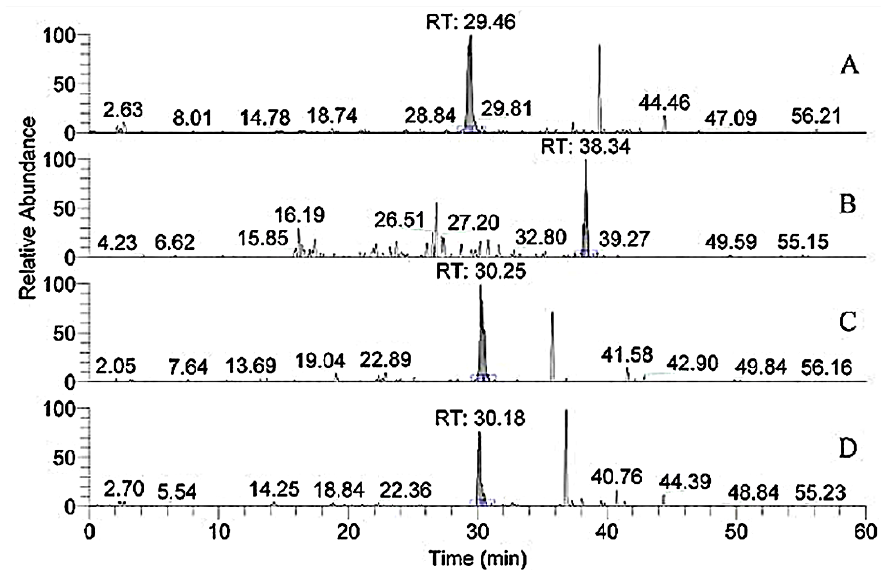
Figure 6. Extracted ion chromatogram of the peptides, numbers 1–4, in Table 1. ( A ) m / z 796.8; ( B ) m / z 1042.3; ( C ) m / z 908.9; ( D ) m / z 780.9.